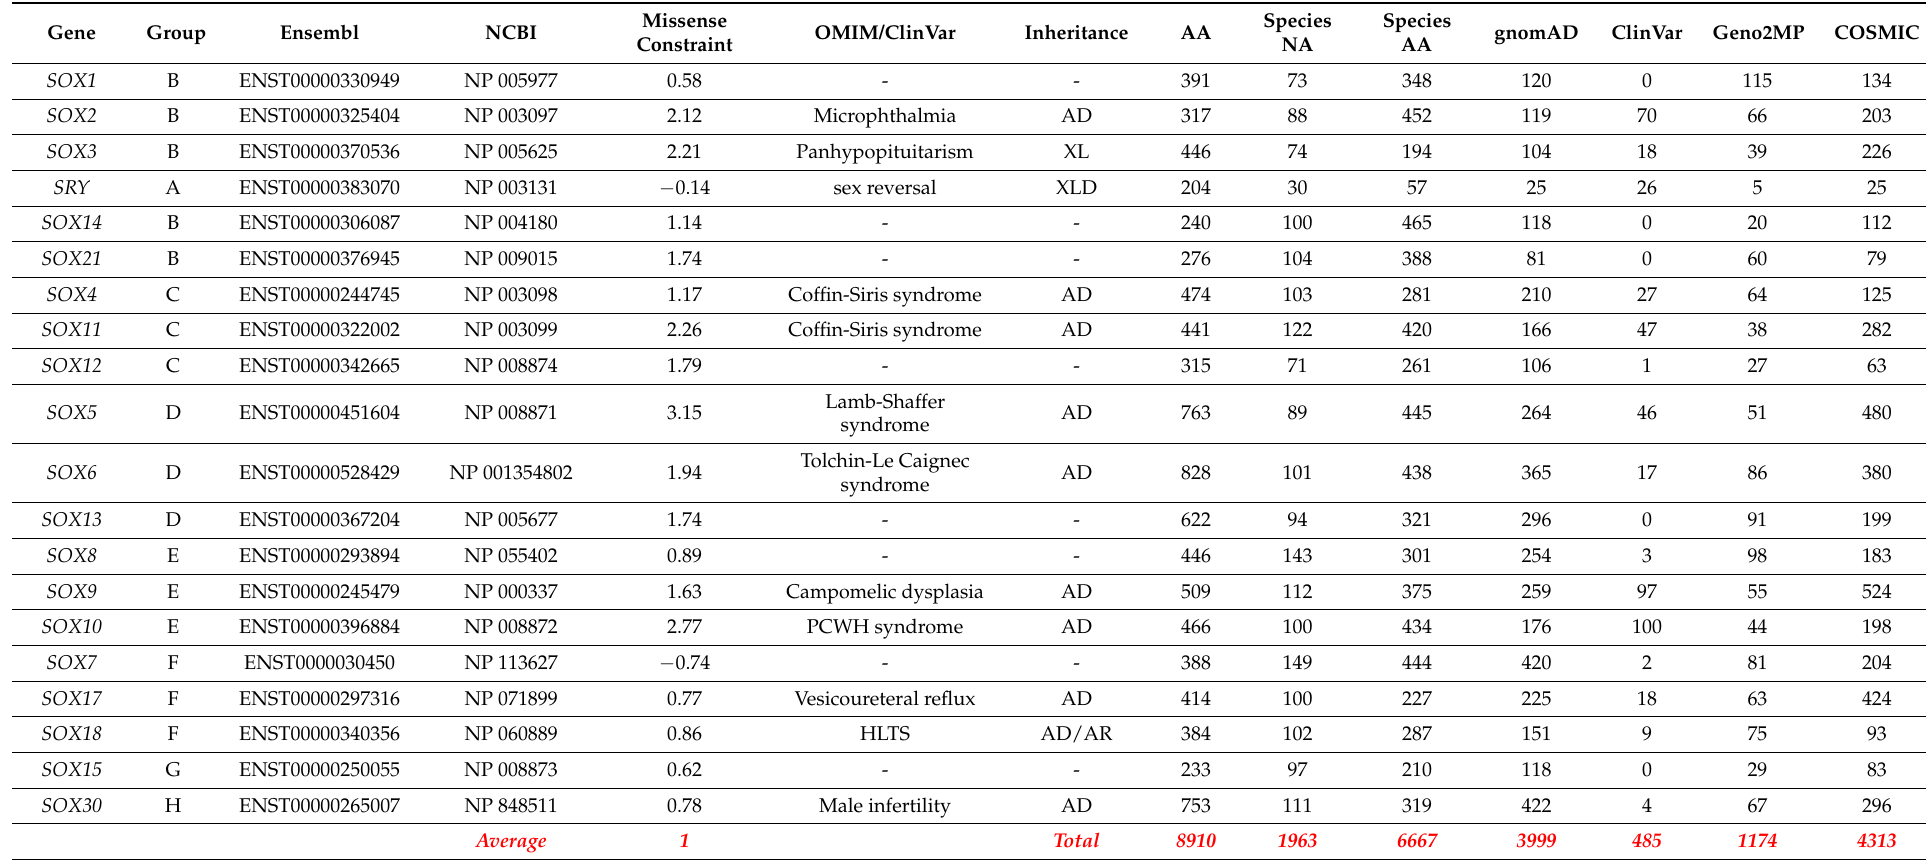
Table 2. SOX genes with known disease associations and mapping data for genomic variants. In red at the bottom are averages or total numbers for various columns. AD—autosomal dominant; XL—X-linked; XLD—X-linked dominant; AR—autosomal recessive; NA—nucleic acid sequences; AA—amino acid